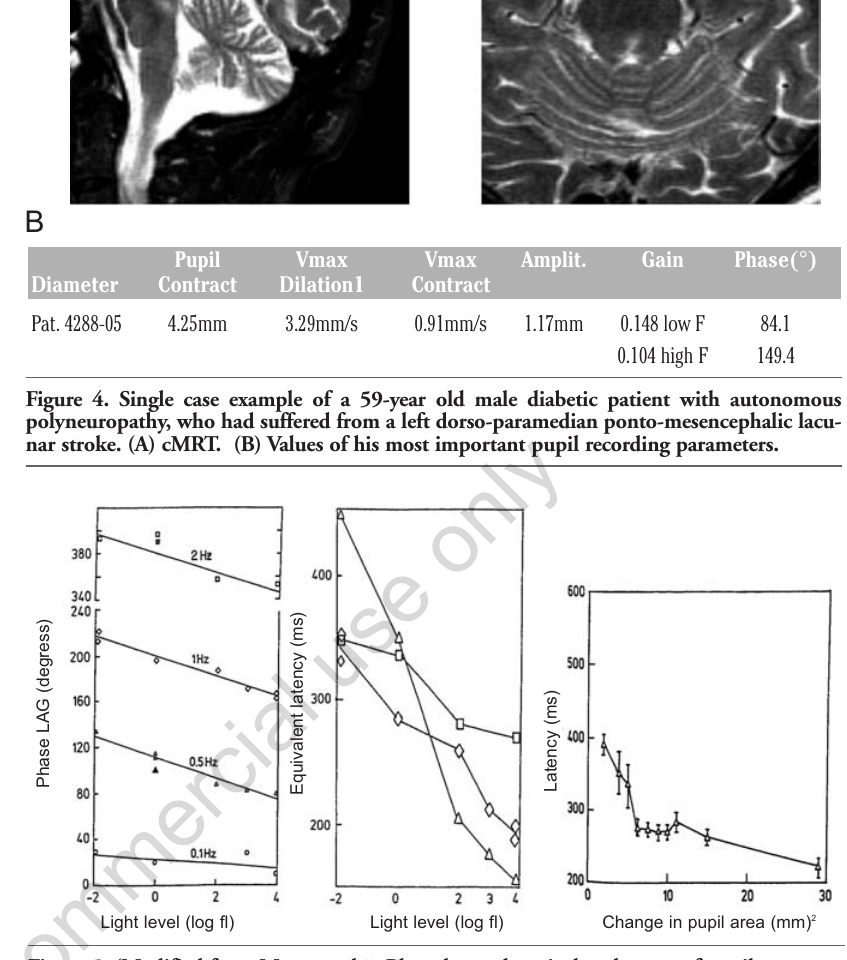
Figure 5. (Modified from Myers et al. 21 . Phase lag and equivalent latency of pupil responses to sinusoidal light stimuli are reduced by increased mean light level. Left: phase lag data. Middle: corresponding equivalent latencies computed from phase lag by subtracting the minimum phase component then dividing by angular frequency in °/sec; subj. JCA. Right: latency of pPLR as function of response size. Note that in the light-pupil responses the response size increases with increasing stimulus size. Results are for subject GM, 20 respons- es per